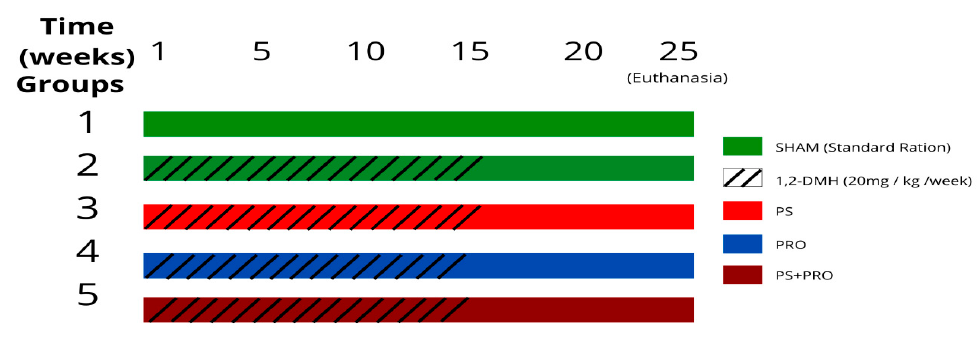
Figure 1. Experiment